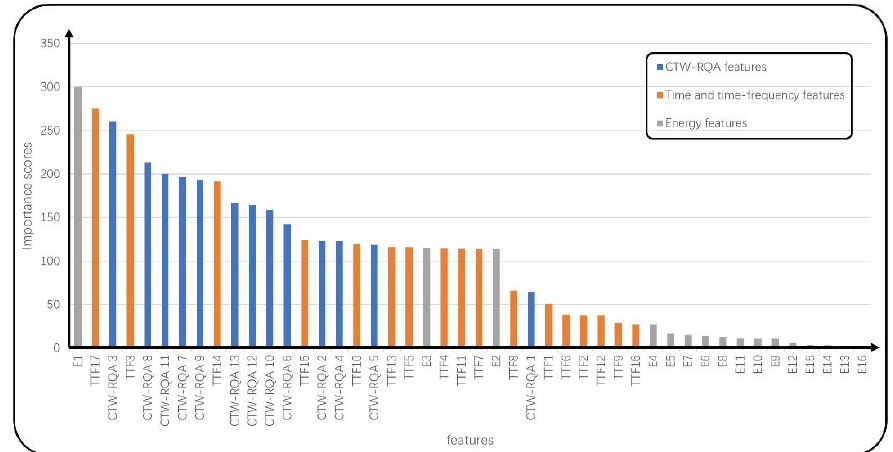
Figure 6. The ranking results of fusion features based on the chi-square test.